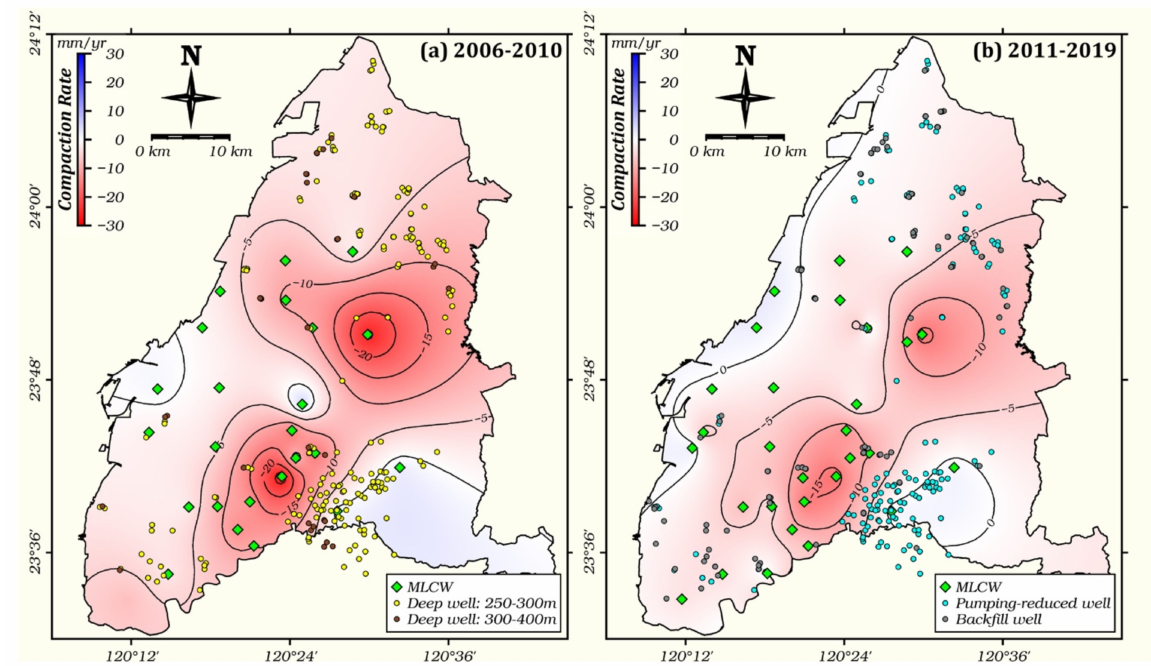
Figure 10. Average deep compactions at intervals of 5 mm/yr in the CRAF from ( a ) 2006–2010 and ( b ) 2011–2019.